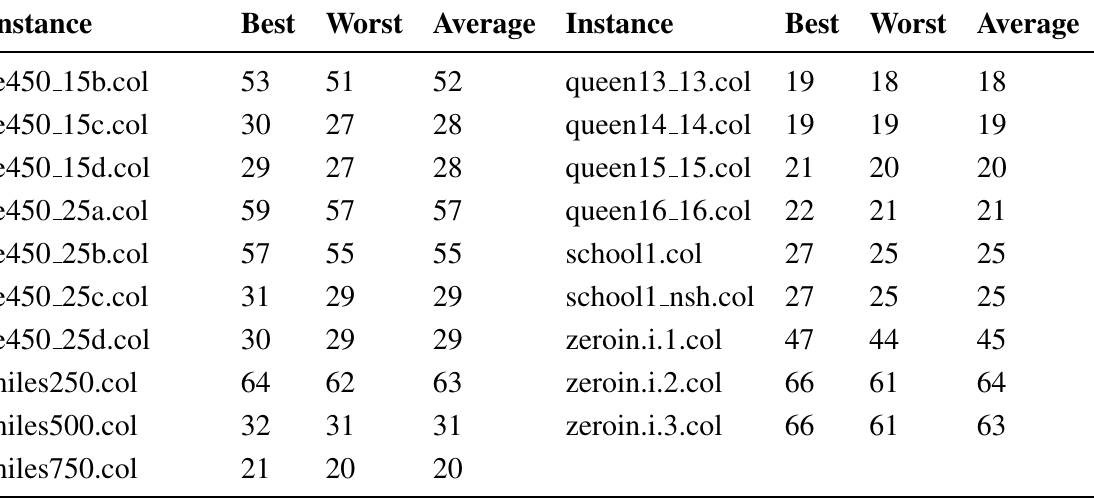
Table 6. Results for VNS2 with k